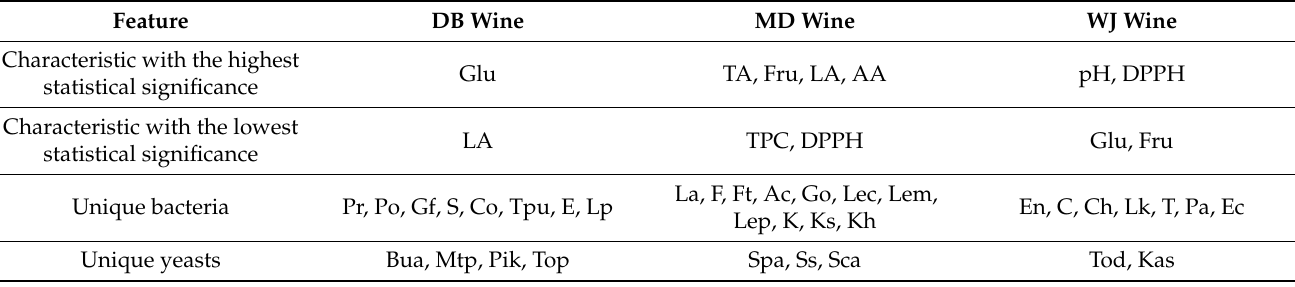
Table 5. Unique features of the studied wines.